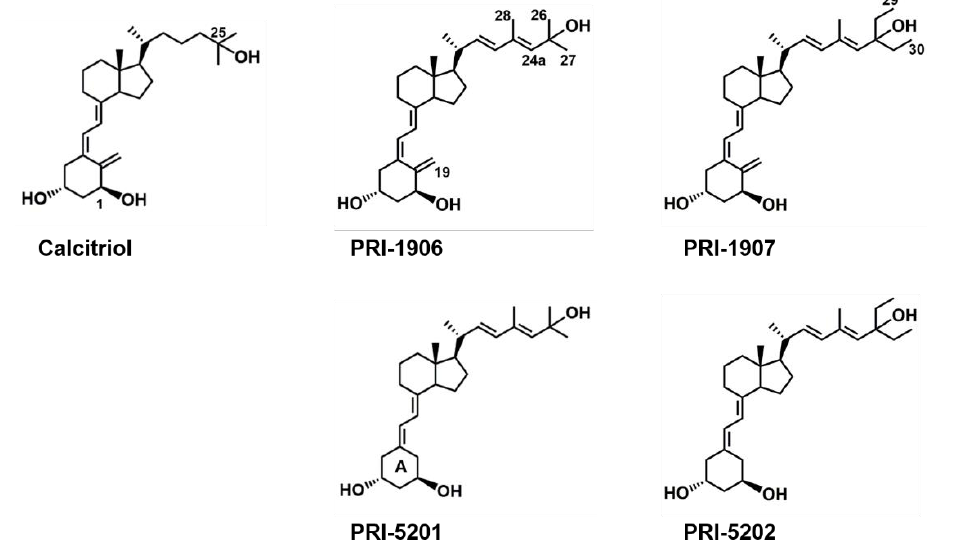
Figure 1. Chemical structures of calcitriol and the tested vitamin D analogs PRI-1906, PRI-1907, PRI-5201, and PRI-5202. Some carbons and rings are specifically labeled due to their structural importance (see discussion section).